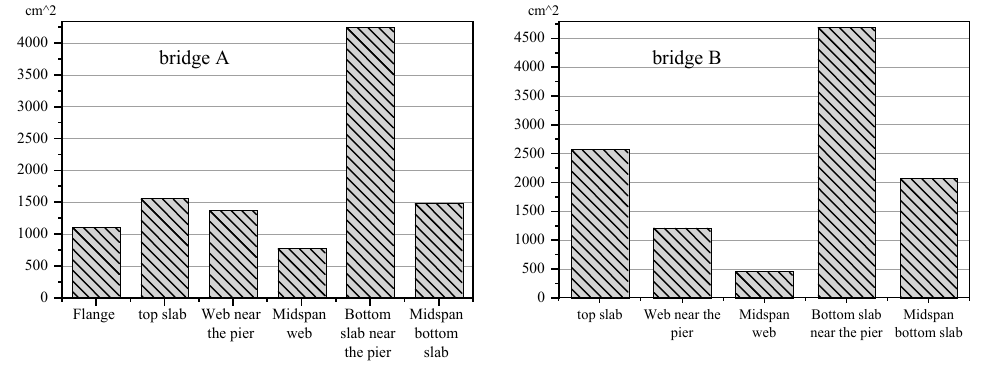
Figure 15. Weighted deviation area at different sectional parts.